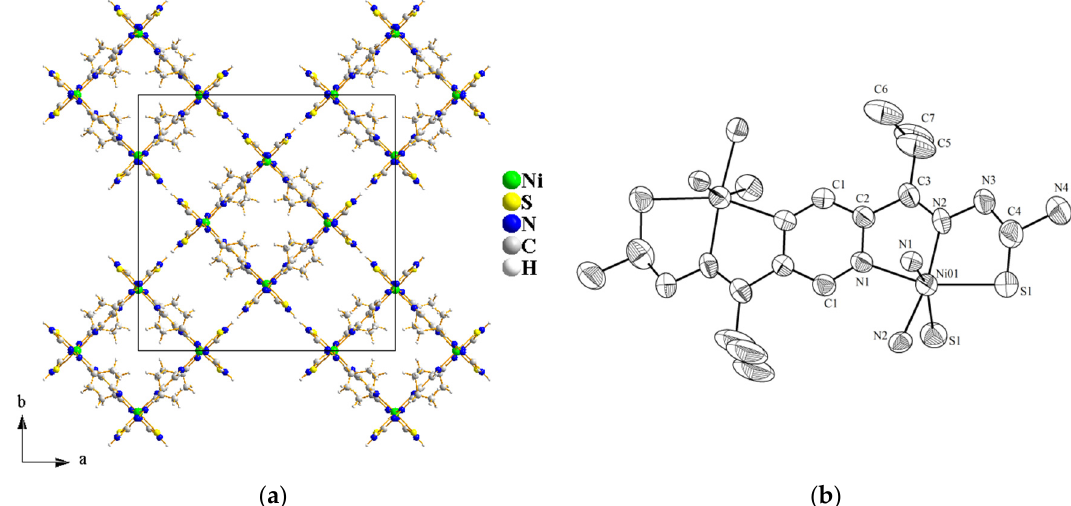
Figure 3. Crystal structure of [Ni 4 (L i Pr ) 4 ] at 293(2) K, solved in the tetragonal space group I 422 ( R int = 0.0937, R 1 solved (all data) = 0.1087 (0.1611); w R 2 = 0.3048 (0.3617) viewed along the crystallographic c axis ( a ) and an ORTEP plot of the binuclear coordination unit ( b ) shown at 50% probability level; protons were omitted for clarity.